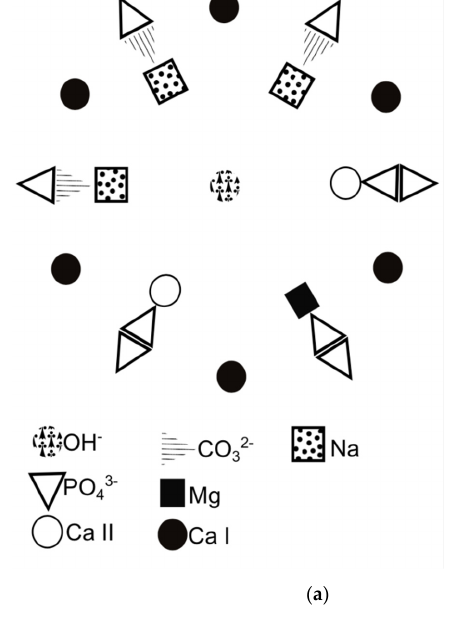
Int. J. Mol. Sci. 2021 , 22 , x FOR PEER REVIEW